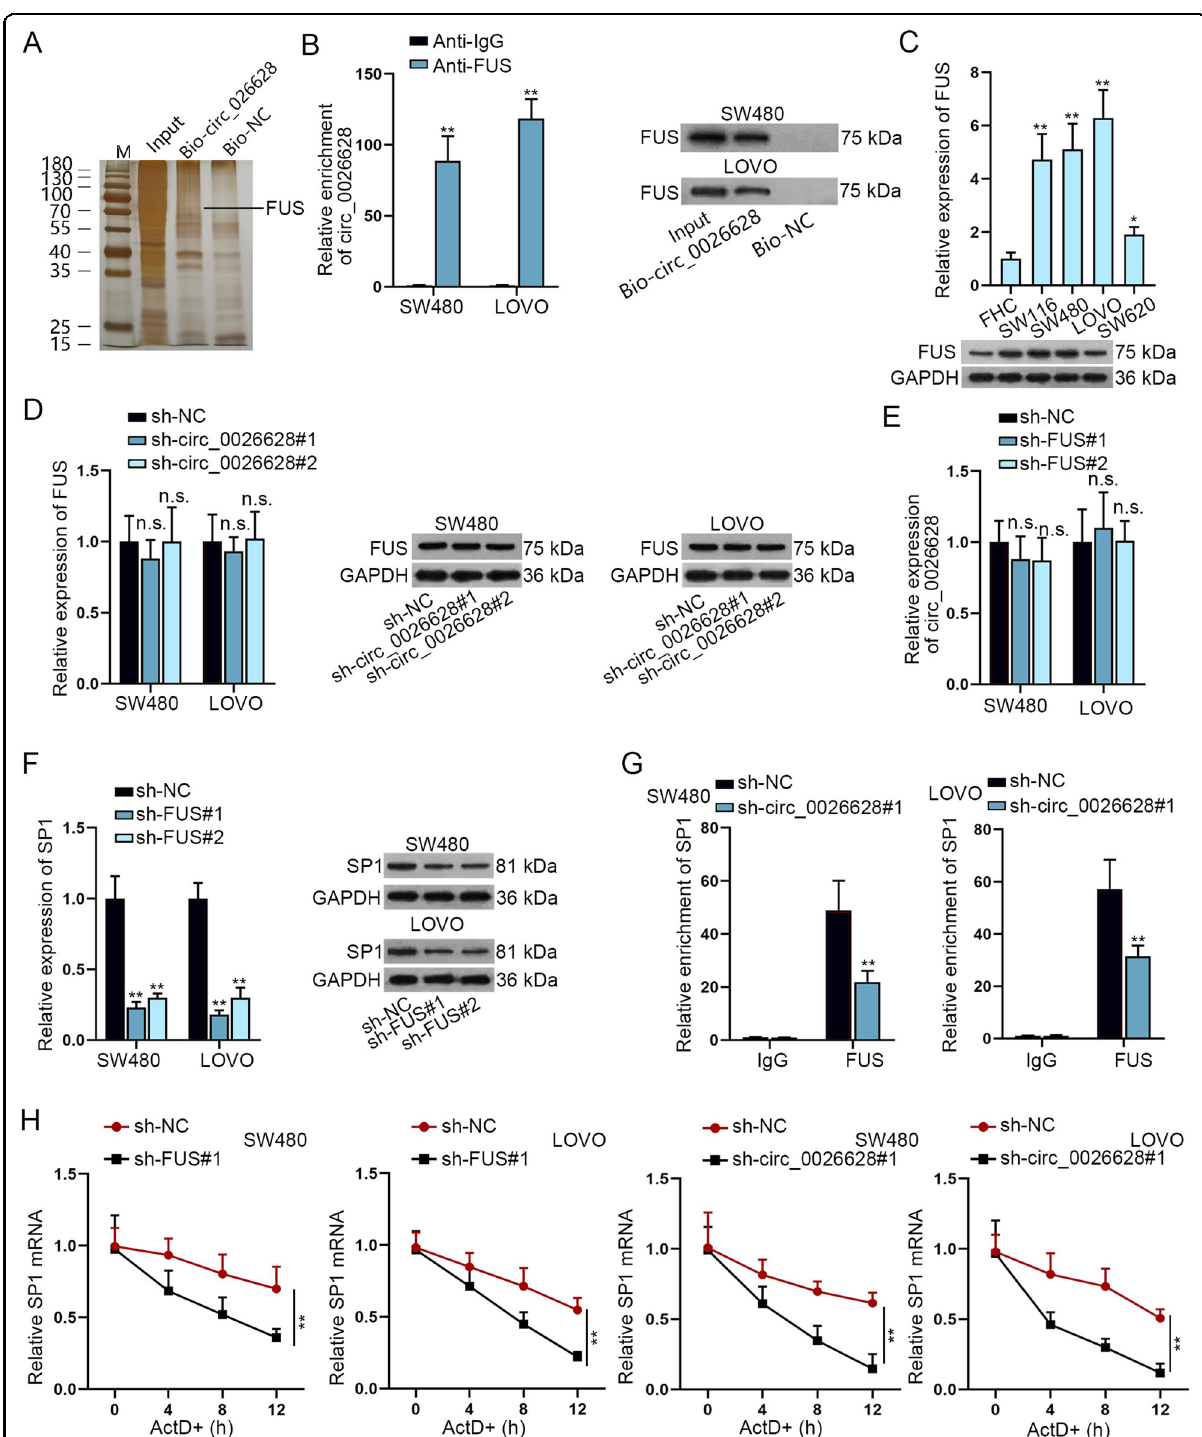
Fig. 5 Circ_0026628 recruited FUS to stabilize SP1. A RNA pull-down followed by mass spectrometry validated FUS as the RBP to bind with circ_0026628. B RNA pull-down and RIP assays further con fi rmed the interaction betweencirc_0026628 and FUS in CRC cells. Student ’ s t -test. C qRT-PCR and western blot disclosed the expression pro fi le of FUS in CRC cells and in control cells. One-way ANOVA. D . qRT-PCR and western blot examined the in fl uence of circ_0026628 depletion on FUS expression. One-way ANOVA. E qRT-PCR revealed the in fl uence of FUS de fi ciency on circ_0026628 expression. One-way ANOVA. F qRT-PCR and western blot revealed the in fl uence of silenced FUS on SP1 expression. One-way ANOVA. G RIP assay tested the enrichment of SP1 precipitated by anti-IgG and anti-FUS when circ_0026628 was silenced or not. Two-way ANOVA. H qRT-PCR detected SP1 mRNA level under ActD treatment in CRC cells with or without circ_0026628 or FUS knockdown. Two-way ANOVA. * P <0.05, ** P <0.01. “ n.s. ” indicates no signi fi cance. Of fi cial journal of the Cell Death Differentiation